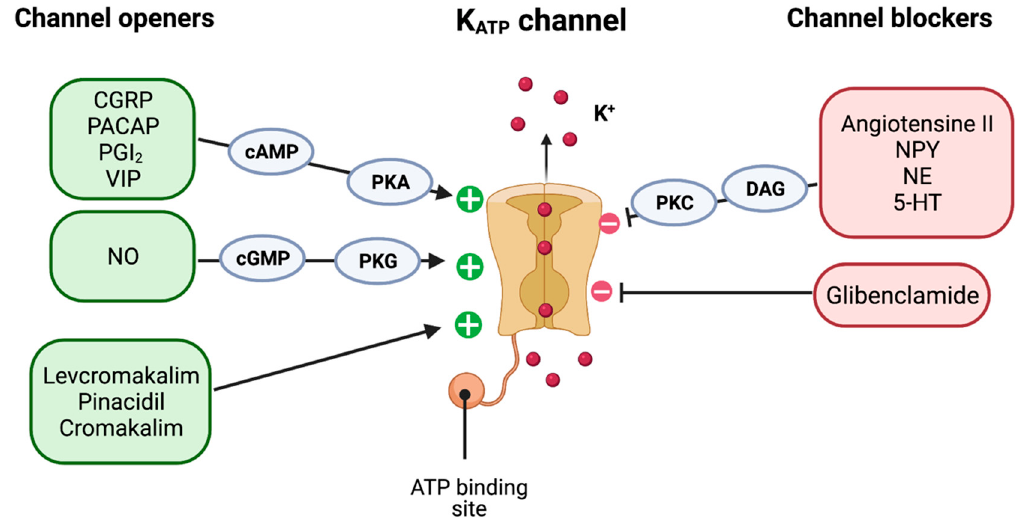
Figure 3. K ATP channel openers and blockers. K ATP channels on smooth muscle cells can be opened by endogenous vasoactive compounds such as CGRP, PACAP, VIP, and NO, and moreover, directly opened by synthetic channel openers (e.g., levcromakalim and pinacidil). Conversely, a DAG-PKC phosphorylation-dependent mechanism is seen in endogenous channel blockers, such as angiotensin II and NE, whereas the synthetic channel blocker glibenclamide directly inhibits the K ATP opening and smooth muscle relaxation. 5-HT = 5-hydroxytryptamine; NE = norepinephrine; NO = nitric oxide; NPY = neuropeptide Y; PGI 2 = prostaglandin I 2 ; and VIP = vasoactive intestinal peptide.